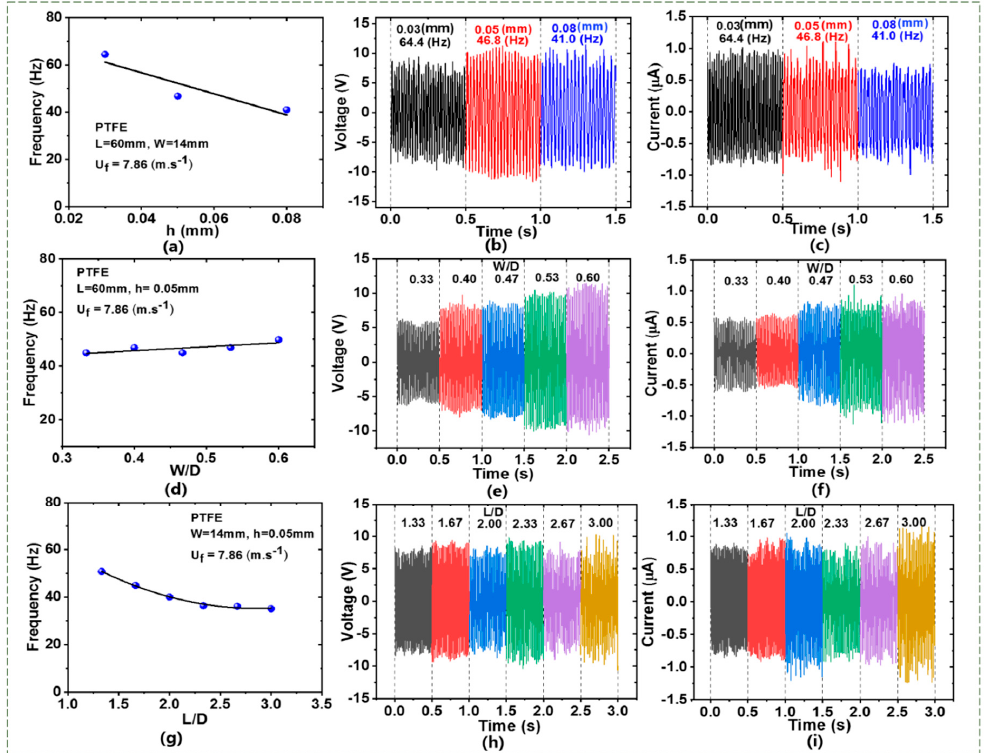
Figure 4. Flutter frequency and electrical characteristics of TENG flowmeter with PTFE membrane at the same airflow velocity of 7.86 m/s. ( a ) Frequency, ( b ) voltage, ( c ) current with different thickness. ( d ) Frequency, ( e ) voltage, ( f ) current with di ff erent width. ( g ) Frequency, ( h ) voltage, ( i ) current with different length.